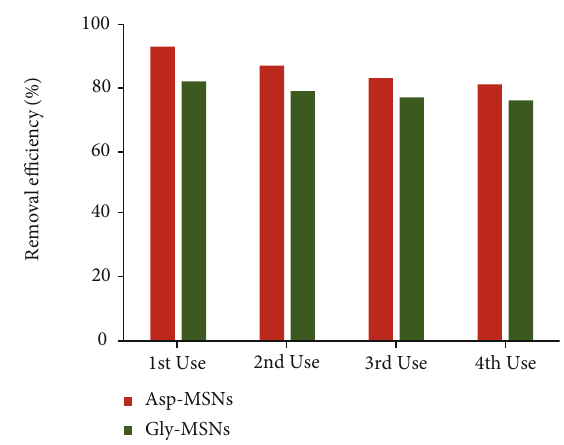
Figure 10: Adsorption e ffi ciency of the fresh Asp-MSNs and Gly- MSNs (1st use) and that of the regenerated nanoadsorbents after two, three, and four uses in the removal of MB from contaminated water at C 0 = 50 mg · L, V =10mL, T =298K, and pH